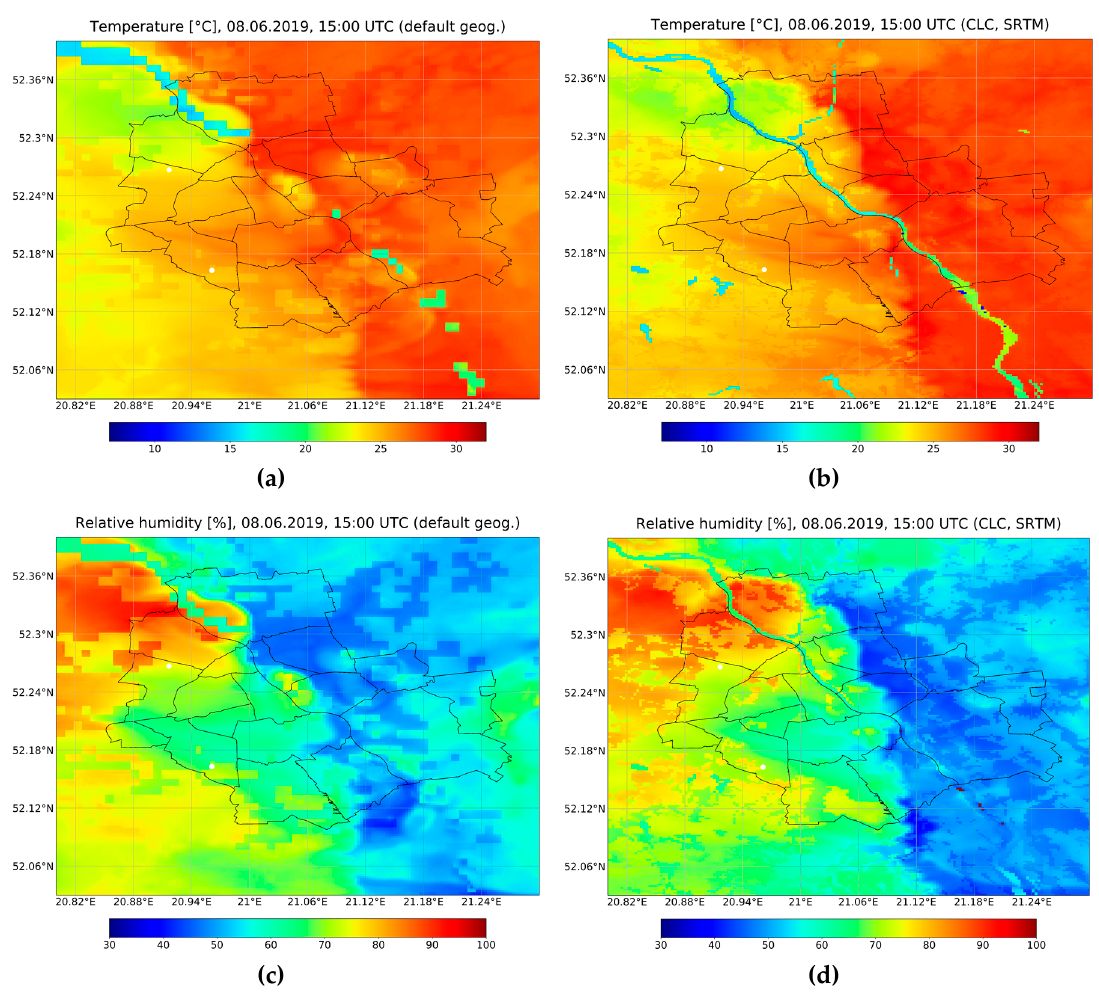
Figure 7. Example of the obtained values of meteorological parameters during frontal synoptic situation on 08.06.2019 at 15:00 UTC. Horizontal distribution of temperature at 2 m (°C) obtained with ( a ) default geographical data; ( b ) CLC and SRTM geographical data. Horizontal distribution of relative humidity (%) obtained with ( c ) default geographical data; ( d ) CLC and SRTM geographical data.